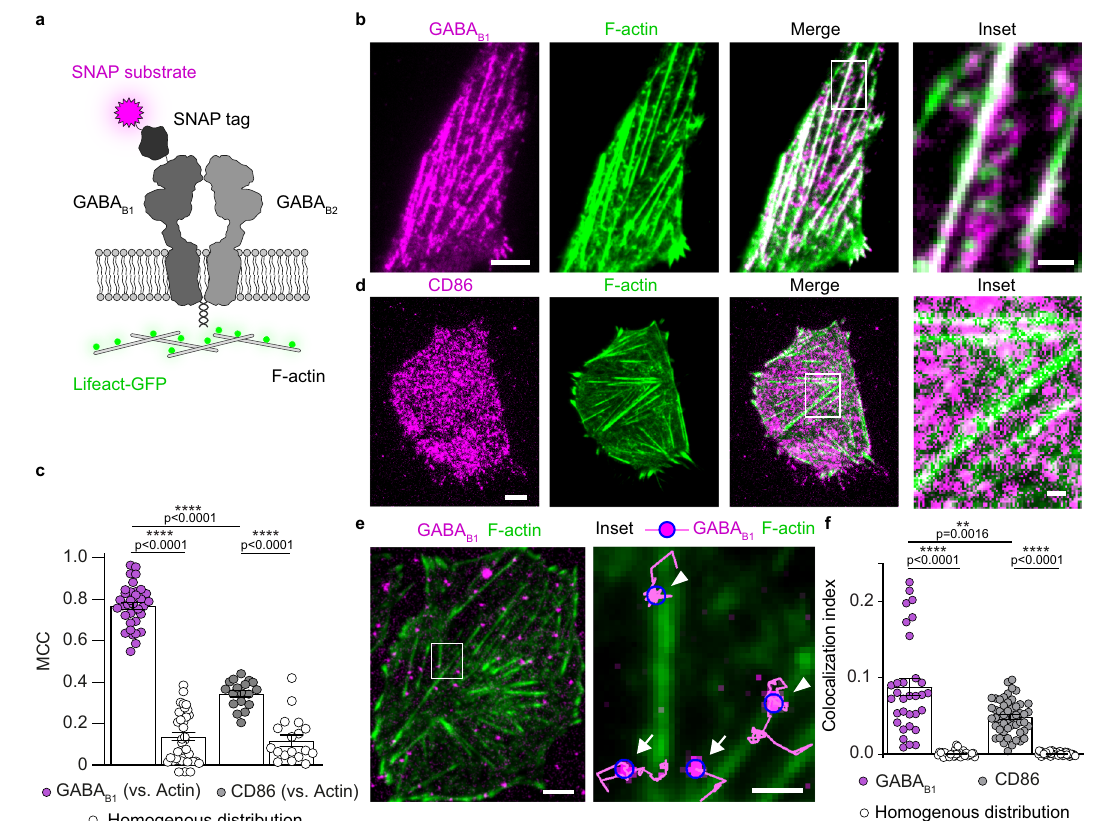
Fig.1|GABA B receptorsaretransientlytetheredalongactin fi bers.a Schemeof theconstructsusedinthestudy.TheGABA B1 constructcontainsaSNAP-tagatitsN- terminus, allowing direct labeling with the fl uorescent benzylguanine derivative SNAP-Surface 549 (SNAP-549). b Representative TIRF images of CHO cells co- transfected with SNAP-GABA B1 (magenta), GABA B2 , and Lifeact-GFP (green) for 24h. The inset corresponds to the region delimited by the white box. c Quanti fi cation of GABA B and CD86 colocalization with F-actin. Shown are Man- ders ’ colocalization coef fi cient (MCC) values compared with those expected for homogenous GABA B distributions or observed with CD86. The bars show mean± SEMvalues.n=35cellsand18cells(GABA B andCD86,respectively)examinedover three independent experiments. **** p <0.0001 by two-tailed unpaired Welch ’ s t-test. d Representative TIRF images of CHO cells co-transfected with SNAP-CD86